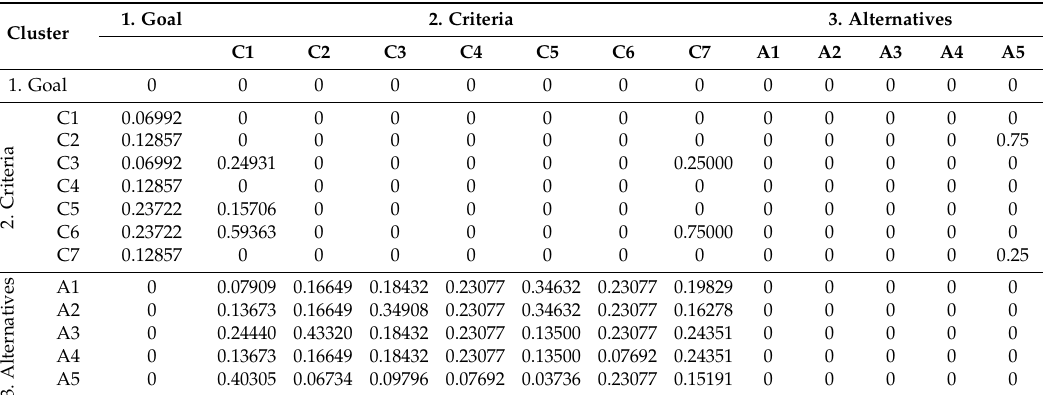
Table A1. The unweighted supermatrix.